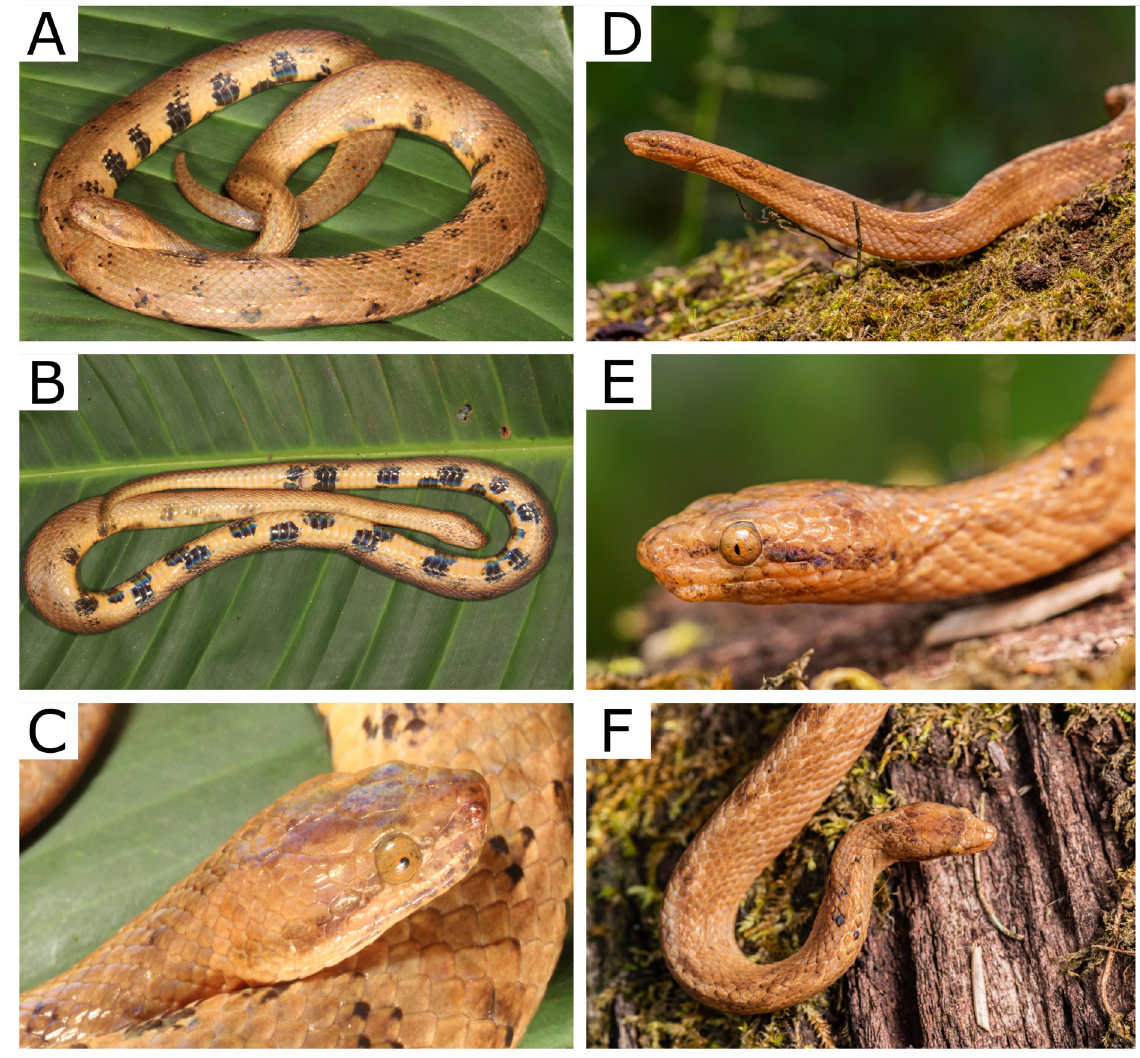
Fig. 7. Head views of Tropidophis cacuangoae sp. nov. in life. A–C . ♂, holotype (DHMECN 16725). D–F . ♀, paratype (DHMECN 15893). Photograph credits: A–C = H. Mauricio Ortega-Andrade; D–F= Danilo